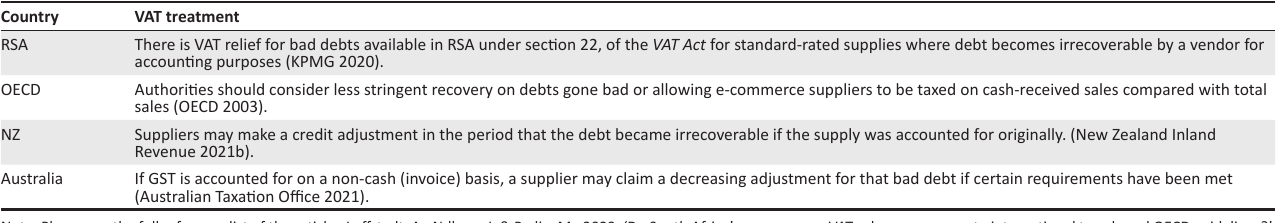
TABLE 6: A comparison of the value-added tax treatment of bad debts in Republic of South Africa, Organisation for Economic Co-operation and Development guidelines, New Zealand and Australia. Country VAT treatment